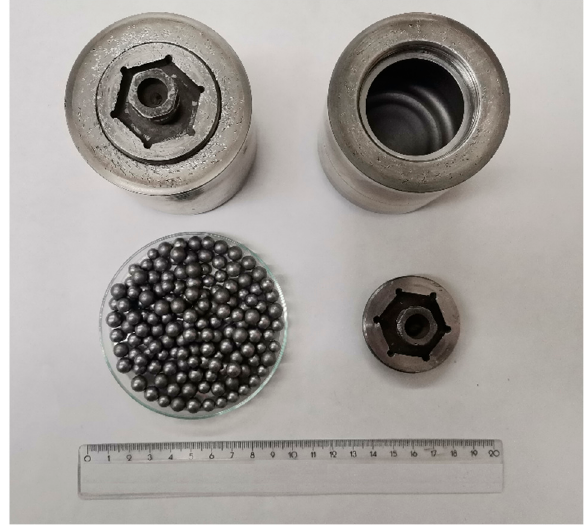
Figure 3. Steel vials and steel balls used for MA.